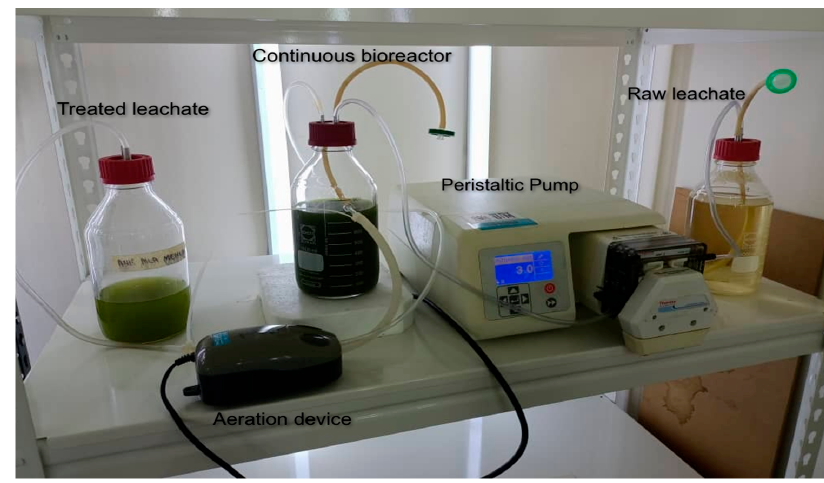
Figure 4. Laboratory photograph of the experiment.